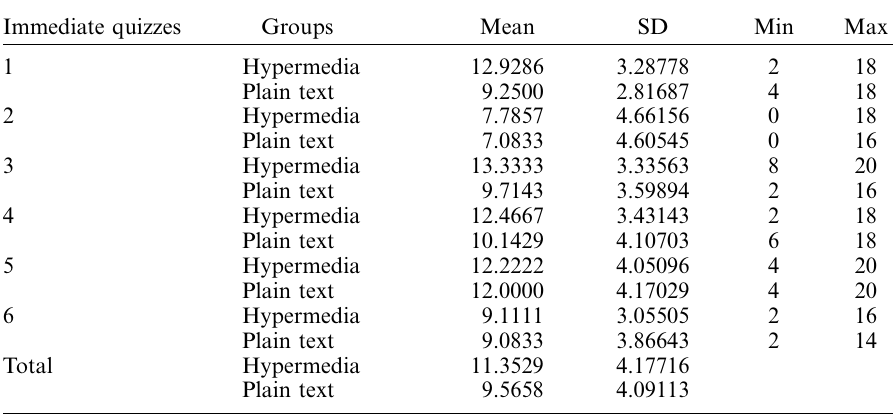
Table 2. Descriptive statistics for immediate quizzes.